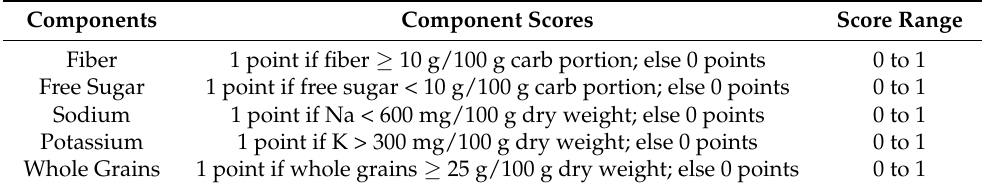
Table 1. Carbohydrate Food Quality Score (CFQS) Components.